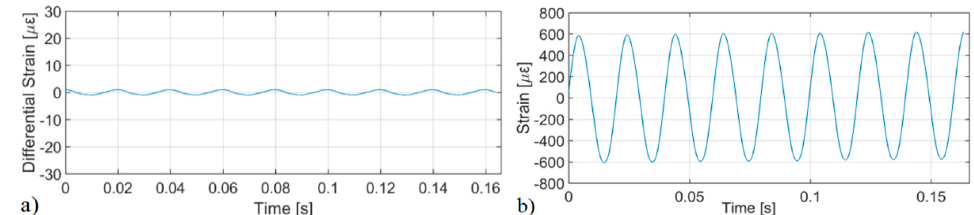
Figure 13. (From [39]) Measurement of large strain (50 Hz, 1190 µε (peak-to-peak) vibration) using CP- Φ OTDR, τ p = 35 ns (3.5 m spatial resolution), δυ p = 5 GHz and f s , ac = 200 kHz, after 5-point median filter of differential strains: ( a ) shot-to-shot differential strain ( b ) measured strain, @2019 IEEE [39].